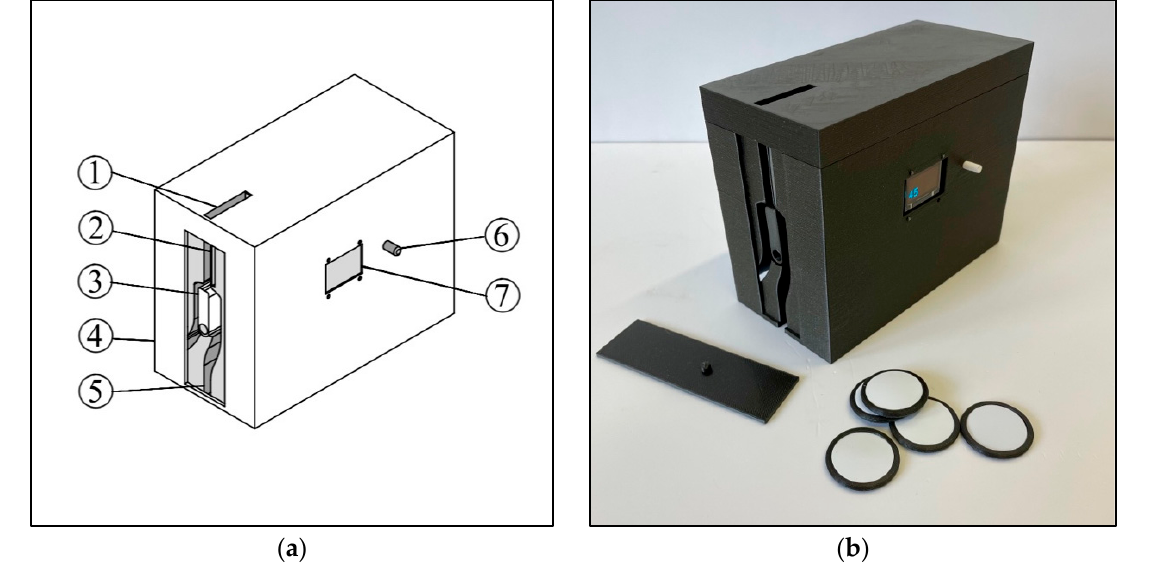
Figure 2. Prototype of the polarization analogy module. ( a ) Isometric view: (1) entry slot for near-field communication (NFC) chips, (2) location of the embedded radio-frequency identification (RFID) module to interact with NFC chips, (3) hinged flap to guide chips after reading/writing, (4) back exit slot, (5) bottom exit slot, (6) control knob, (7) organic light-emitting diode (OLED) display. ( b ) Photo of the 3-dimensional (3D)-printed model and NFC chips: Values from 0 to 90 can be set by turning the control knob next to the display. This value will be programmed into the chips on their way through the system. The white coin-sized NFC chips are encapsulated in a black cover to improve operability by increasing their grip. A removable side panel reveals the inner paths.